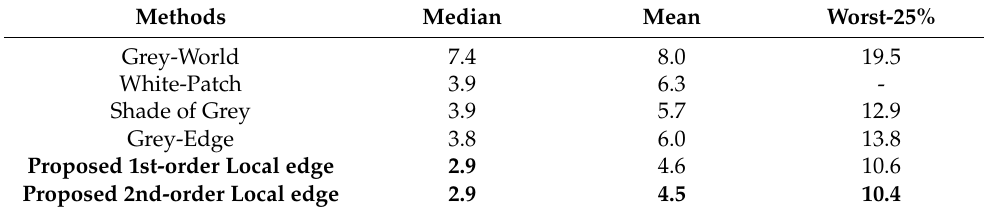
Table 6. Performance of different color constancy methods on the SFU HDR image